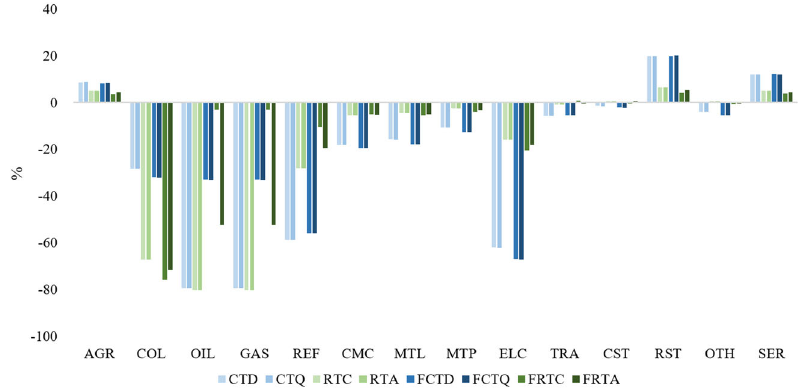
Fig. 8 Export changes in 2030. Blue bars are scenarios imposing carbon taxes, and green bars are scenarios imposing resource taxes. Deeper colors represent free market condition in these scenarios. Please refer to Table 2 for industry abbreviations.